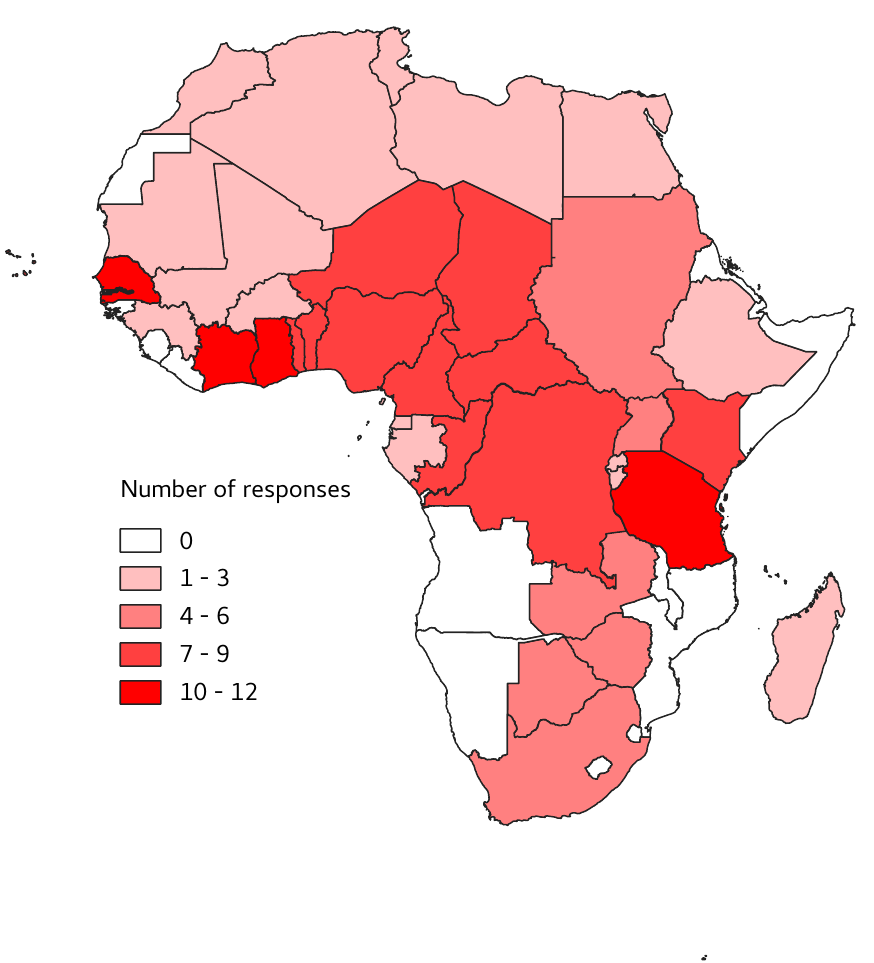
Figure 3. Distribution of the responses received depending on the GMES & Africa consortia. See main text for more detailed